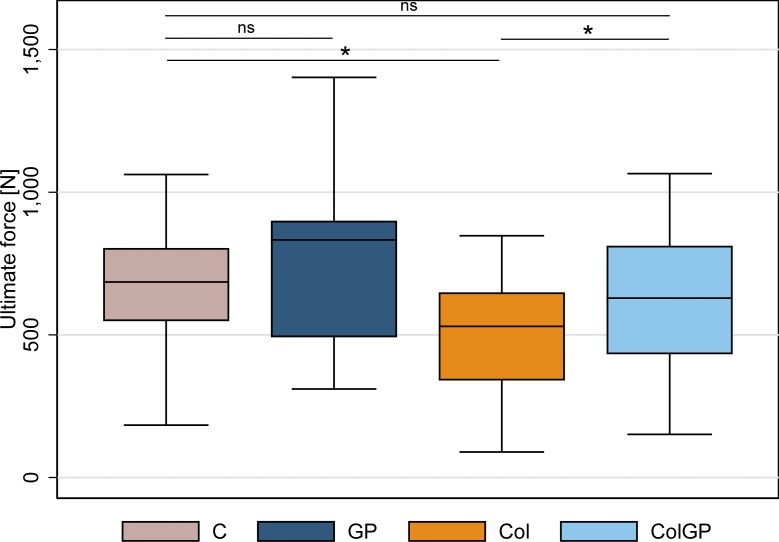
Box plots of ultimate force [N] across groups.Group notation: C healthy control; GP healthy GP-treated; Col degenerated control; ColGP degenerated GP-treated. Median comparison by Dunn’s test. * denotes p-value≤0.05, ns denotes not significant with p>0.05.